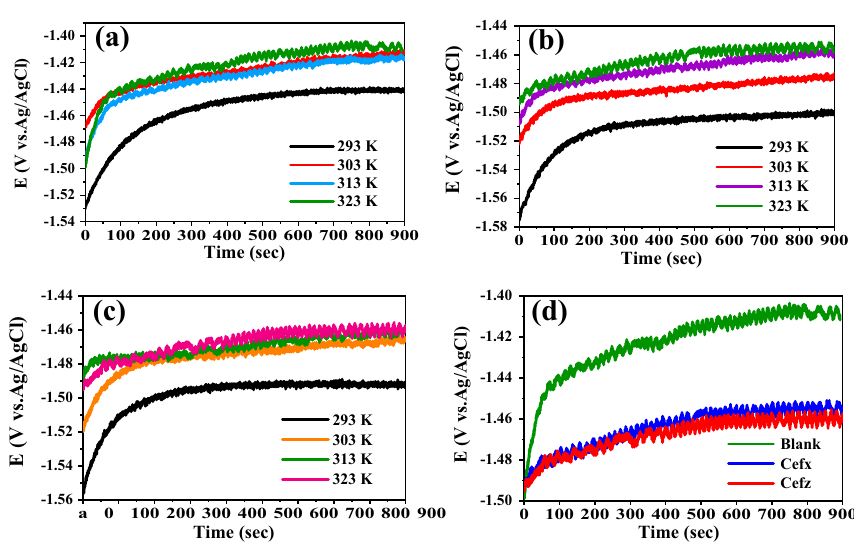
Figure 3. OCP curves of Al in 0.1 M NaOH solution in the absence and presence of 300 ppm of Cefx and Cefz drugs at different temperatures: ( a ) blank, ( b ) Cefx, ( c ) Cefz and ( d ) Blank, Cefx and Cefz at 323